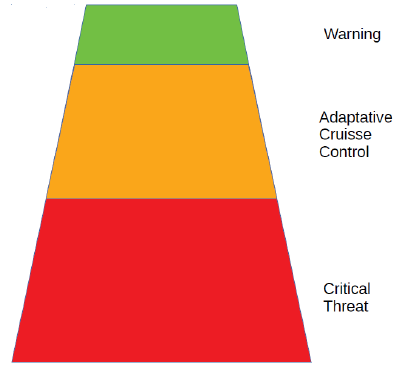
Figure 14. Obstacle